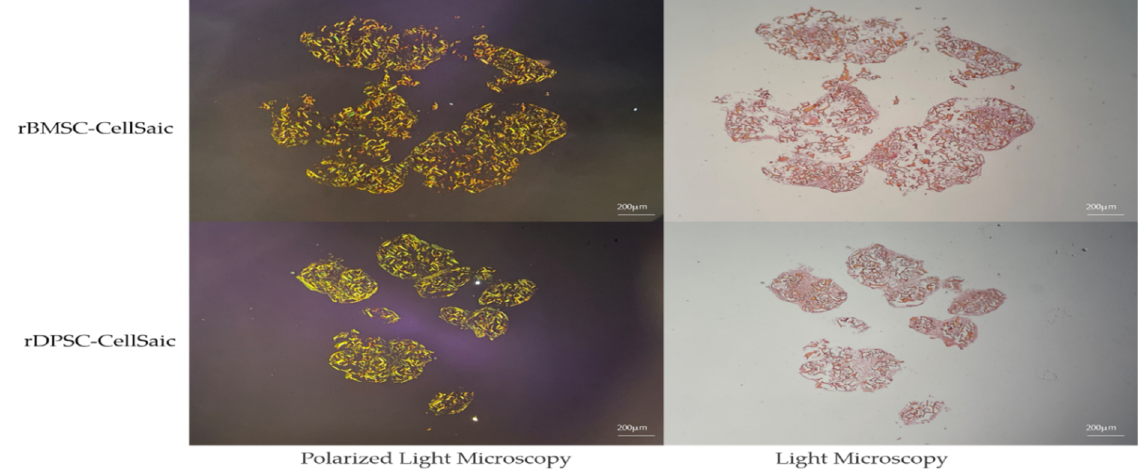
Figure 6. Picro Sirius Red staining under polarized light microscope and ordinary light microscope (Slice thickness = 5 µm, Scale bar = 200 µm).